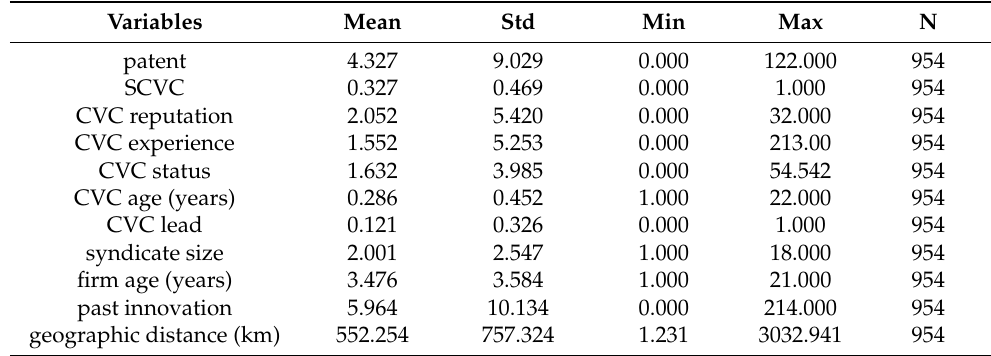
Table 2. Summary statistics.